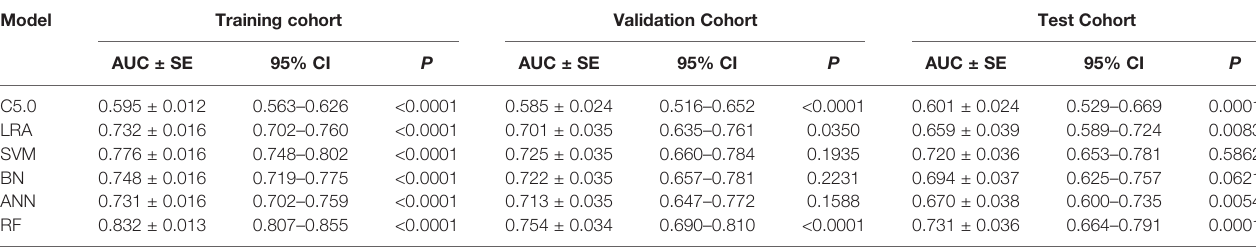
TABLE 2 | Predictive performance of the six machine learning models for the training, validation, and test cohorts. Model